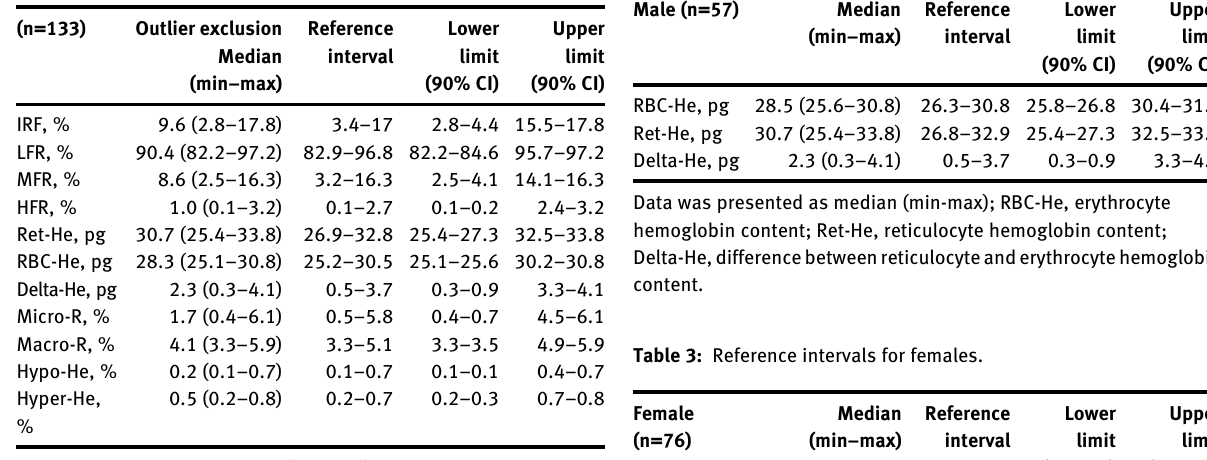
Table  : Reference intervals for males.